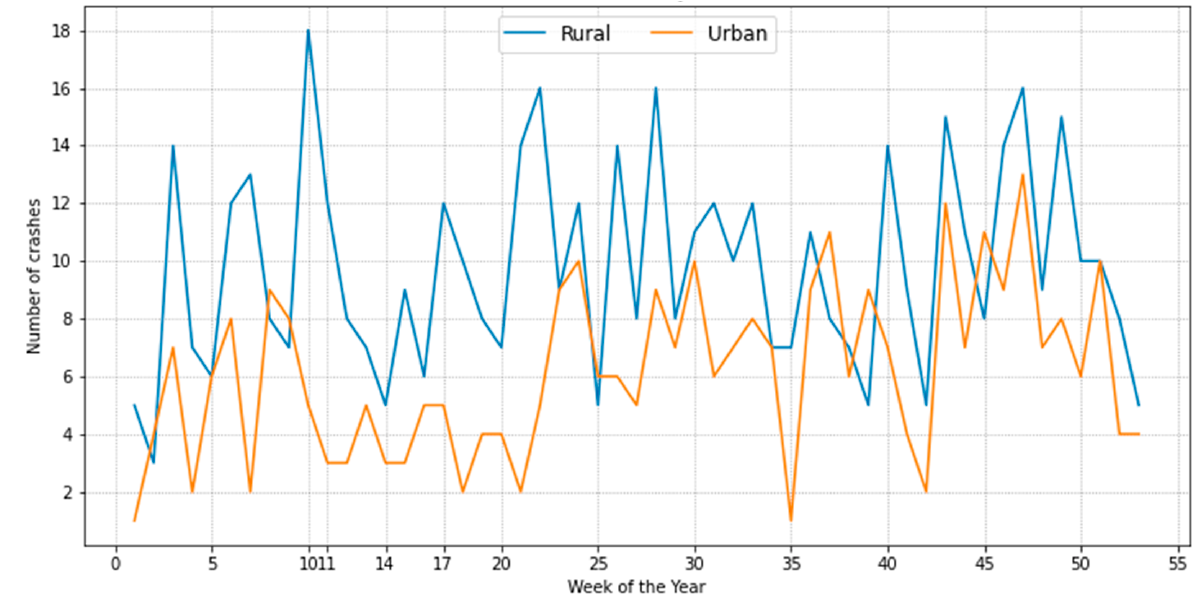
Figure 2. Distribution of fatal crashes by week of the year.